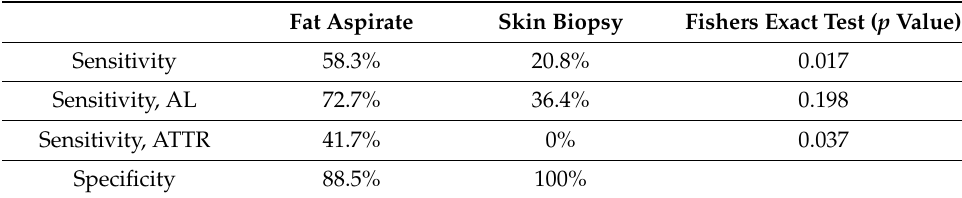
Table 2. The sensitivity and specificity of fat aspirate and skin biopsy,